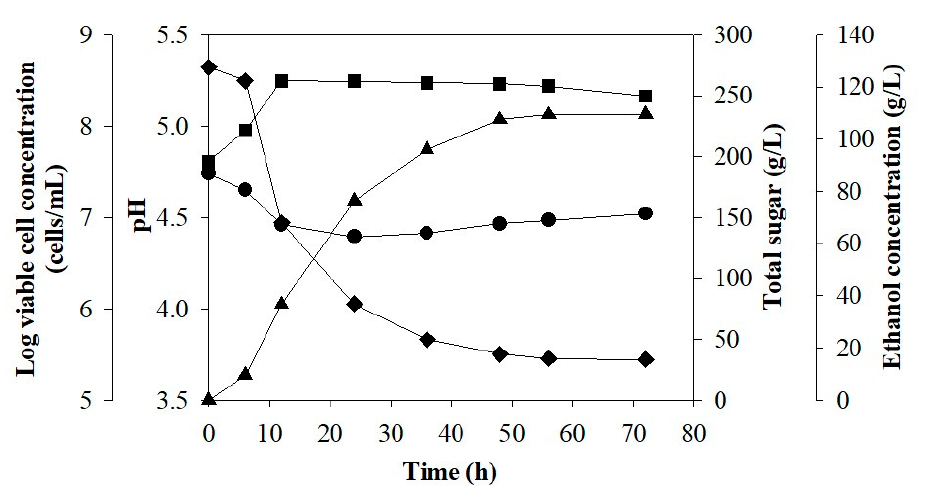
Energies 2019 , 12 , x FOR PEER REVIEW Figure 1. Ethanol fermentation profiles of Run 1 from the sweet sorghum juice supplemented with yeast extract (1 g / L), DSY (4 g / L), and glycine (1 g / L) by S. cerevisiae NP01 ( (cid:4) = log viable cells, (cid:8) = pH,